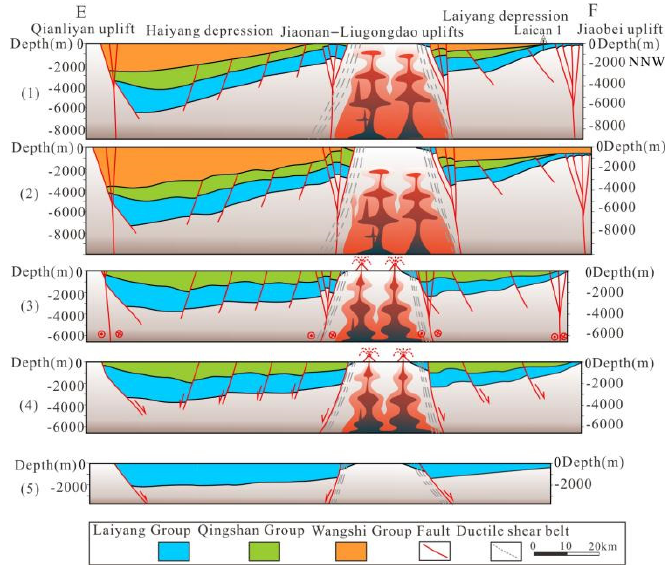
Figure 6. Profile of tectonic evolution map of NNW trending section in the Ri − Qing − Wei basin (see Figure 1 for the section location): (1) late Wangshi period; (2) Wangshi period; (3) late Qingshan period; (4) Qingshan period; and (5) late Laiyang period.